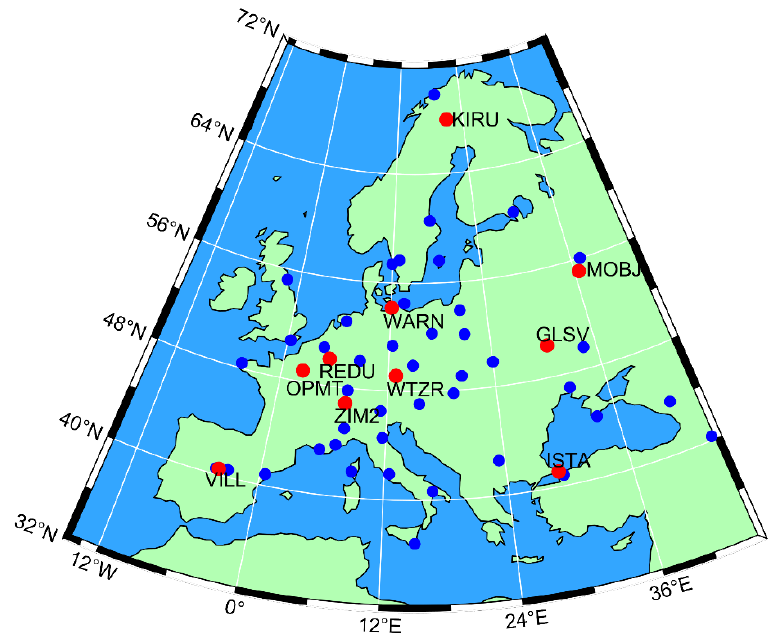
Figure 4. Distribution of experimental IGS stations in January 2018. Blue spots represent the training sites, and 10 testing sites are shown by red points.